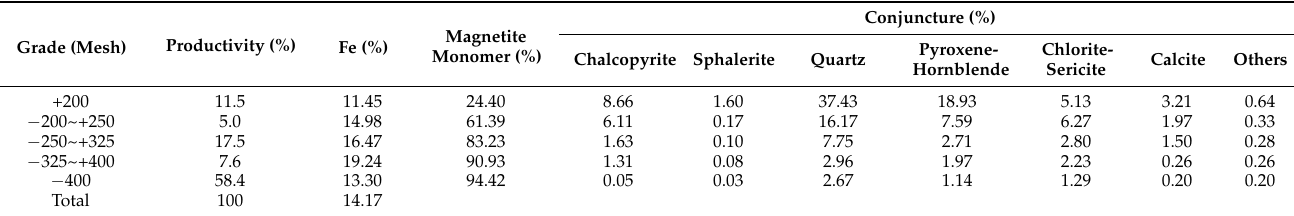
Table 8. Monomer dissociation of magnetite in each size fraction.